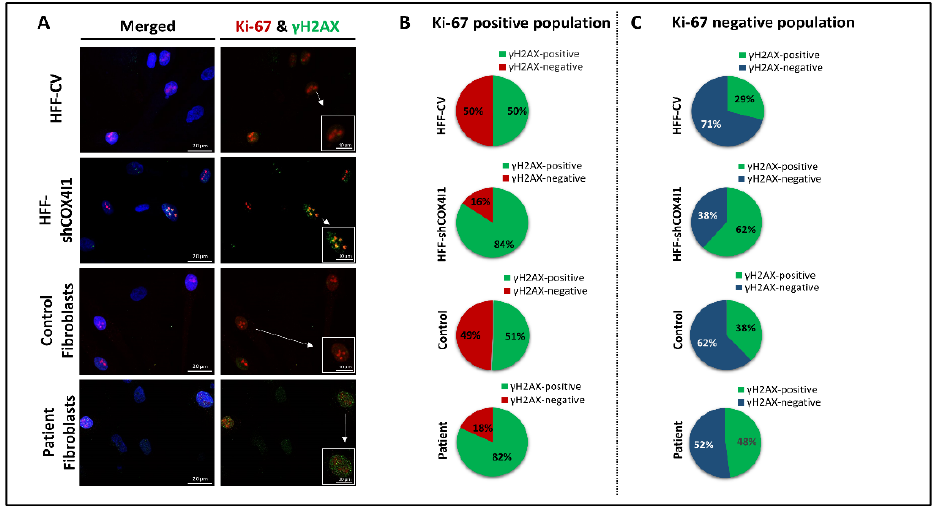
Figure 1. High levels of DSB coincide with Ki-67-positive cells in COX4-1-deficient cells. Both COX4-1-deficient cells (HFF-shCOX4I1 and patient) and their corresponding controls (HFF-CV and healthy control) from similar passages were seeded in equal amounts overnight on tissue culture slides and were fixed and stained simultaneously for γ H2AX (green) and Ki-67 (red). Nuclei were visualized by Hoechst-3334 (blue) ( A ). The pie charts represent the distribution of DSBs ( γ H2AX, green) in proliferative (Ki-67-positive ( B )) and in nonproliferative cells (Ki-67-negative ( C )). At least 100 nuclei of each group of cells were analyzed and quantified. Increased colocalization of Ki-67 and γ H2AX was observed in both COX4-1-deficient cells relative to corresponding controls.